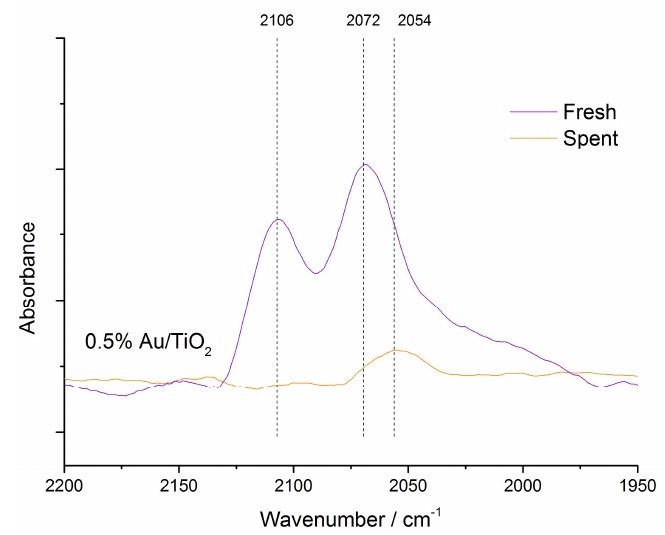
Figure 7. CO-DRIFT spectra over 0.5 wt. % Au/TiO 2 samples before and after the photocatalytic CO 2 reduction .